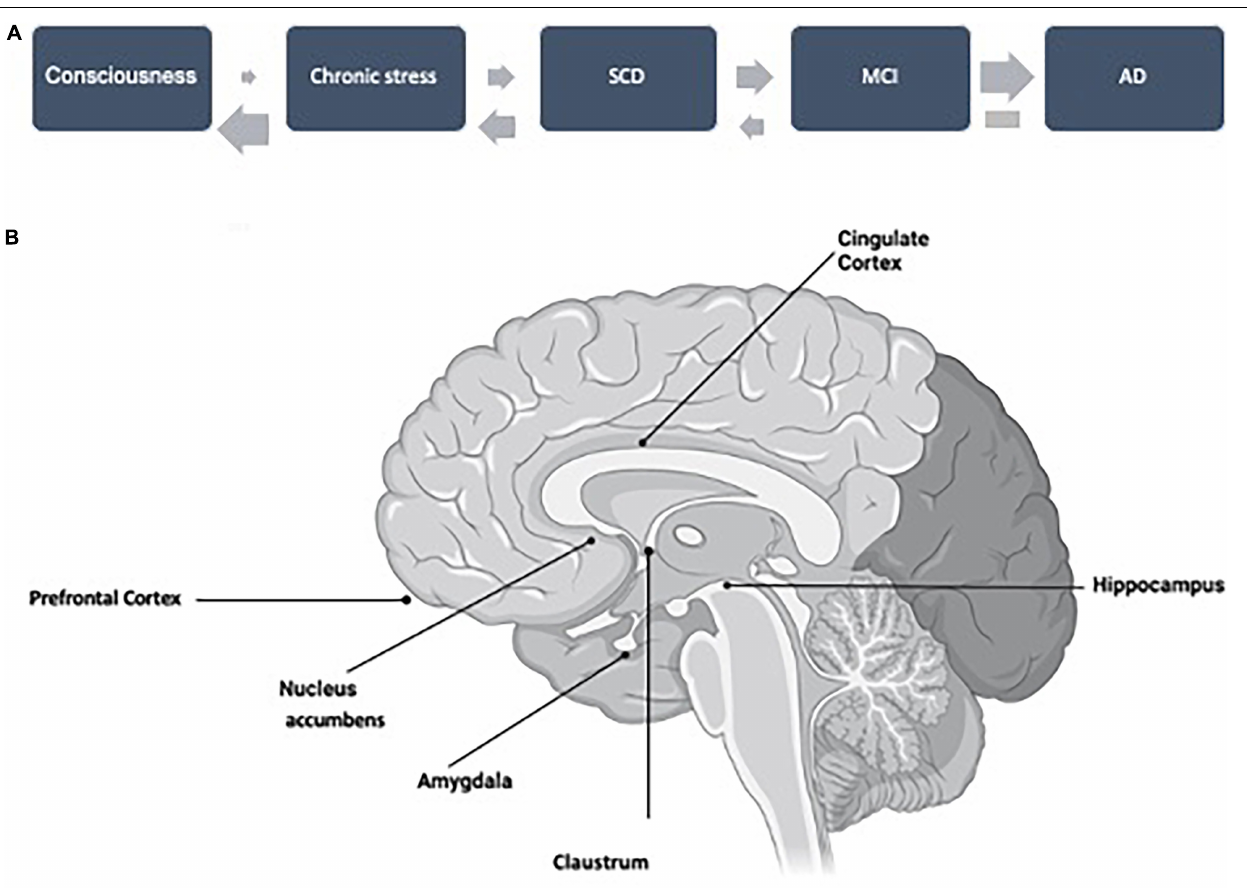
FIGURE 1 | (A) A working hypothesis for the AD continuum, starting with a putative change in consciousness, related to amyloid pathology, followed by features that could facilitate the development of the continuum like chronic stress, SCD, and MCI. The probability of transition (upper arrows) is increasing step by step. These steps could be reverted but not that from AD (dementia), with an inversion probability (lower arrows). (B) Profile of an open brain sagittal section indicating the location of the brain structures mentioned throughout this minireview.